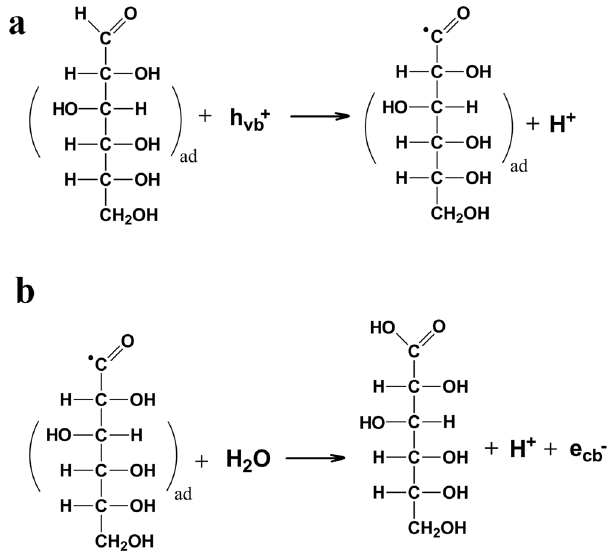
Fig. 3 Suggested pathway for the photo-oxidation of glucose into gluconic acid. Sketch a represents a positive hole transfer to the adsorbed molecule of glucose followed by injection by the reactive intermediate of an electron into the CB of WO 3 , shown in sketch b , to form gluconic acid.